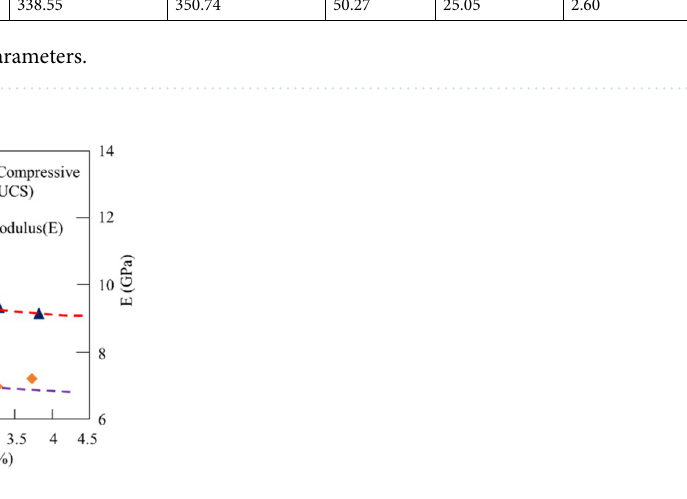
Figure 5. Relationship between rock strength parameters and moisture content of mud